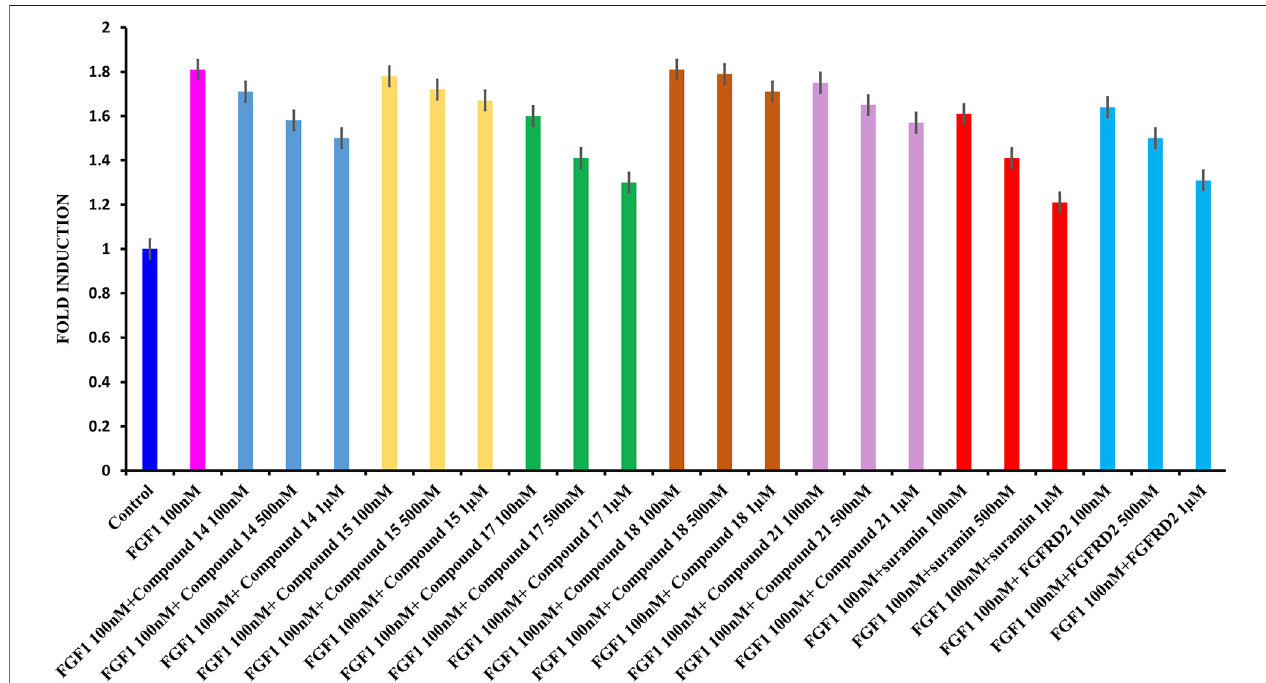
FIGURE5| WST1ASSAYresultsforcellproliferation. (A) :Fromlefttoright:controlinblue;FGF1inpink(100nM)and100nM,500nM,and1 μ Mofcompound 14 in blue; 100 nM, 500 nM, and 1 μ M of compound 15 in yellow; 100 nM, 500 nM, and 1 μ M of compound 17 in green, 100 nM, 500 nM, and 1 μ M of compound 18 in brown, 100 nM, 500 nM, and 1 μ M of compound 21 in light pink, 100 nM, 500 nM, and 1 μ M of suramin in red, and 100 nM, 500 nM, and 1 μ M of D2 in cyan.